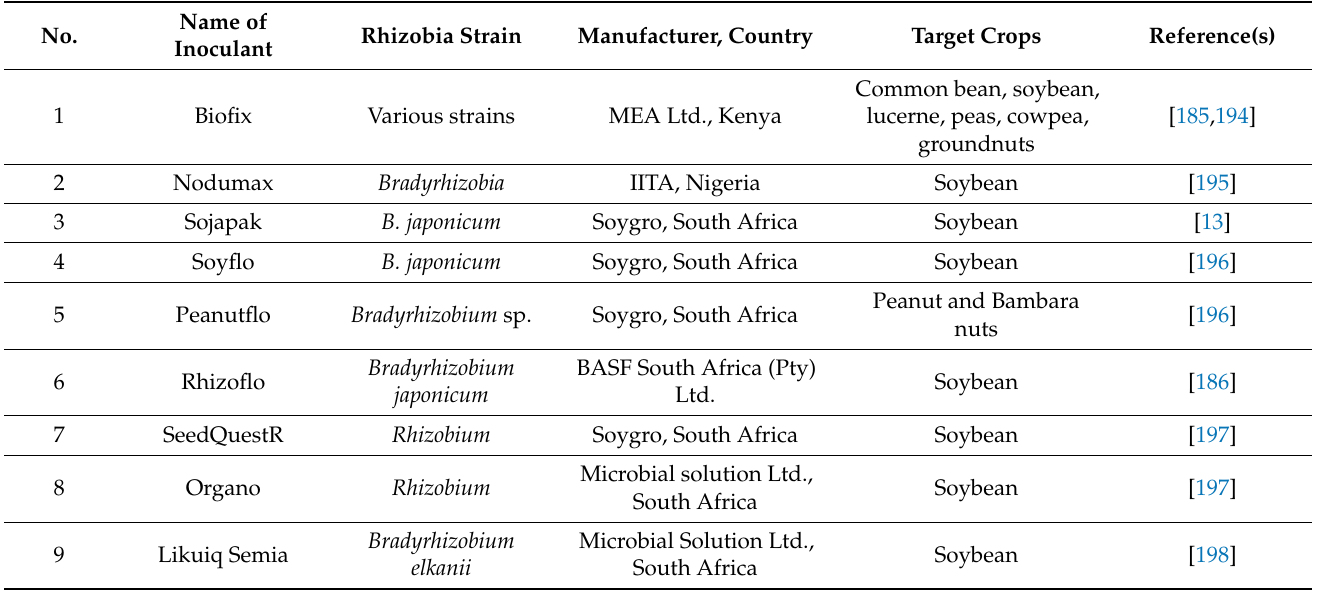
Table 2. Status of the commercialization of rhizobia-based inoculants in